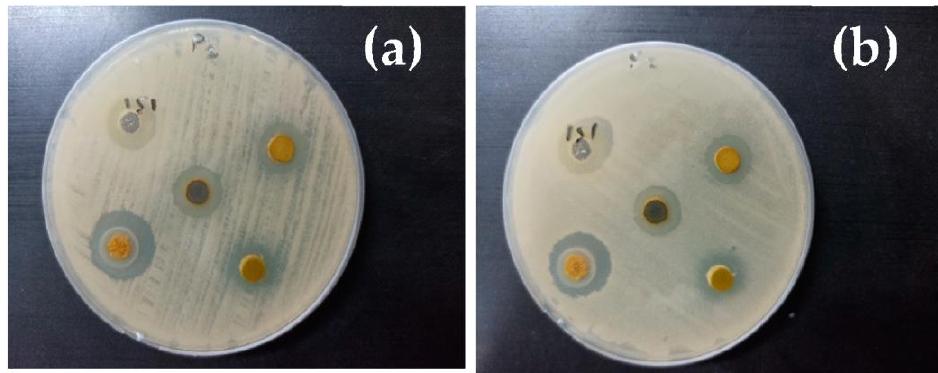
Figure 9. Antibacterial effect of the scaffold films of CS doped with different nanocomposites such as Yb 2 O 3 , V 2 O 5 , and/or GO against ( a ); E. coli and ( b ); S. aureus after 24 h of exposure.